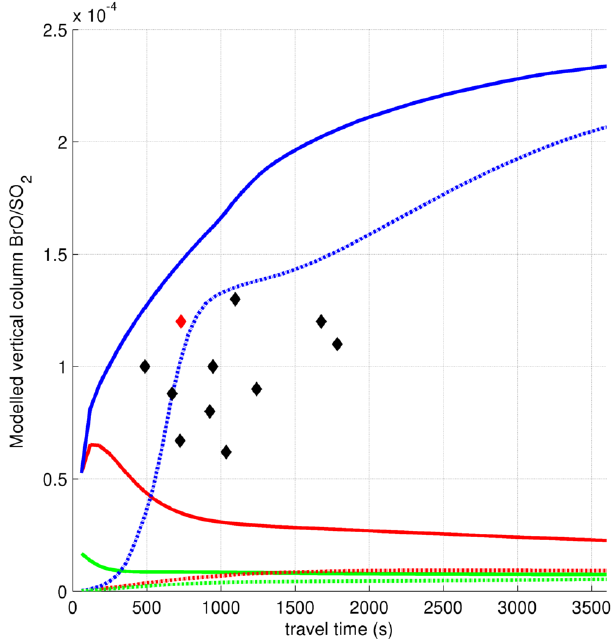
Figure 11. Evolution of vertical column BrO / SO 2 ratios for the six model scenarios discussed in the text (“low Br / S” initialisa- tion). The colour code is the same as in Fig. 7. The black diamonds represent the spectroscopic measurements listed in Table 5, the red diamond represents the 2012-07-27 measurement contemporaneous with near-crater measurements of both O 3 and SO 2 .